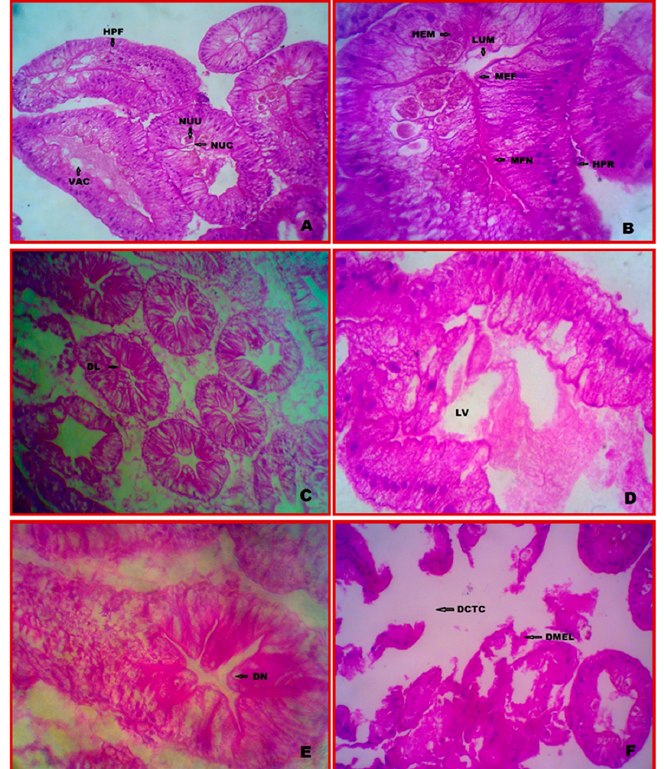
Figure 2. Cytopathological alterations of hepatopancreas in E. tetragonum . A paraffin slice stained with hematoxylin and eosin (40×) under the light microscope: ( A , B ) — control, ( C ) — after 7 days of exposure to chlorpyrifos at a dosage of 0.0294 ppm, ( D ) — after 28 days of exposure to chlorpyrifos at a dosage of 0.0294 ppm, ( E ) — after 7 days of exposure to chlorpyrifos at 0.0588 ppm, ( F ) — after 28 days of exposure to chlorpyrifos at 0.0588 ppm. Abbreviations used: HBF — F-cells, NUC — nucleus, pyrifos at a dosage of 0.0294 ppm, ( E )—after 7 days of exposure to chlorpyrifos at 0.0588